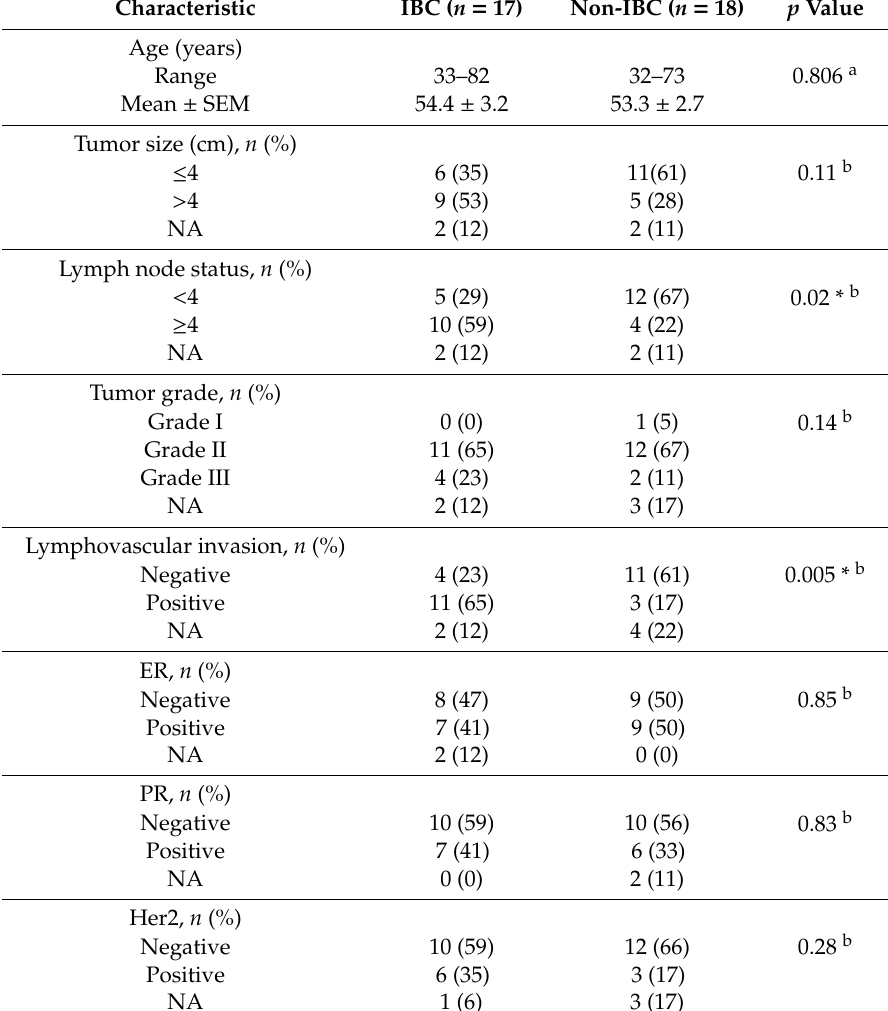
Table 1. Clinic-pathological characteristics of inflammatory breast cancer (IBC) and non-IBC patients.